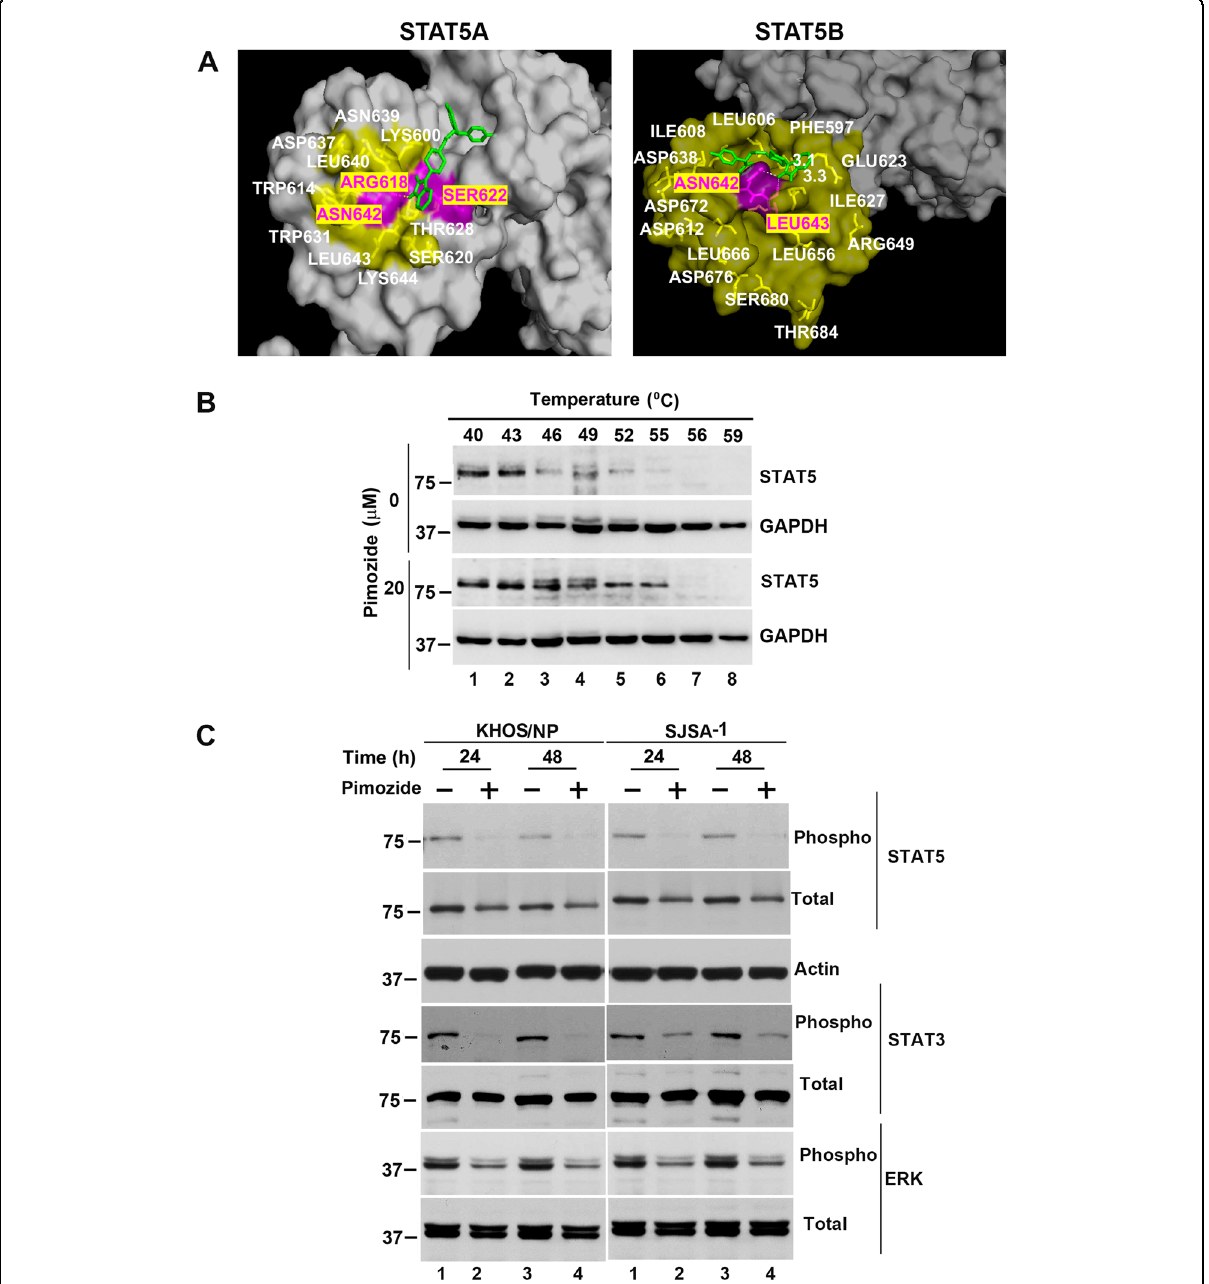
Fig. 4 Pimozide inhibits STAT5 phosphorylation. a Pimozide interacts with the STAT5. We performed molecular docking and determined that pimozide can interact with the SH2 domain of STAT5A and STAT5B with binding energy of − 8.4 and − 6.4 kcal/mol, respectively. b Cellular thermal shift assay (CETSA). KHOS/NP cells were treated with pimozide and subjected to differential temperature treatment for 3 mins. Resulting lysates were subjected to western blot analyses for STAT5. Pimozide protected STAT5 against thermal denaturation suggesting that pimozide-STAT5 interaction. c Lysates from pimozide treated cells caused a signi fi cant decrease in the phosphorylation of STAT5, STAT3, and